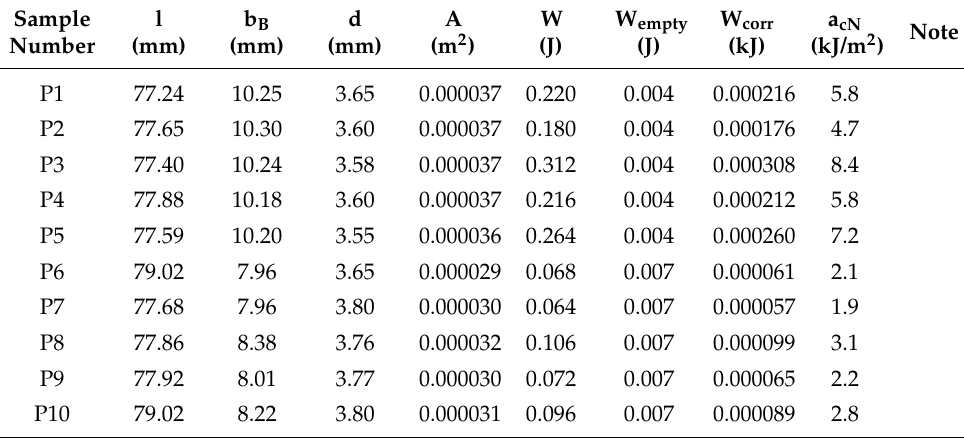
Table A11. Results of the notched impact tests and unnotched impact tests of P_W,PP.